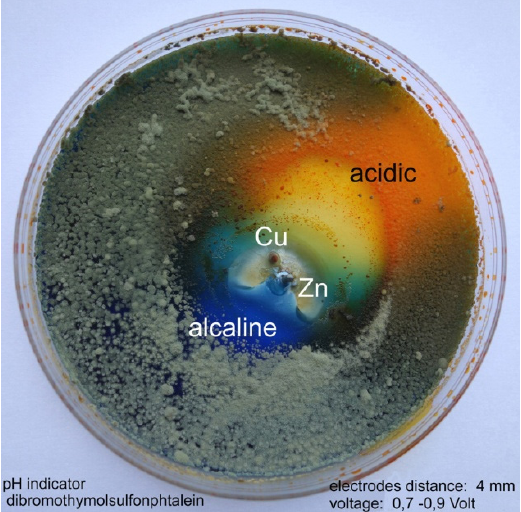
Figure 3. Influence of pH on fungal growth ( Penicillium spinulosum ) as an effect of galvanic action provoked by two electrodes of GALVI systems, photo A. Chlebicki.